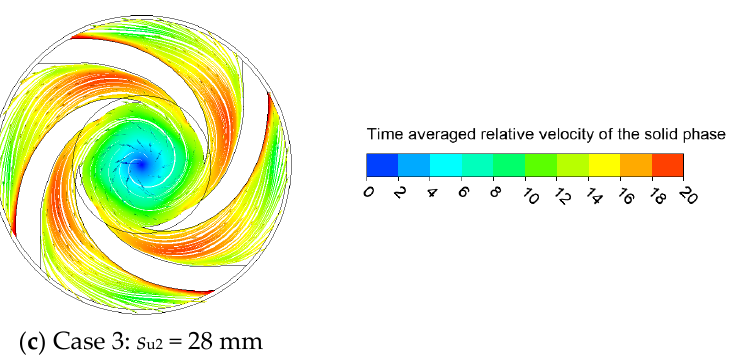
Figure 4. Streamlines of time-averaged relative velocity of the solid particles on the impeller back shroud.